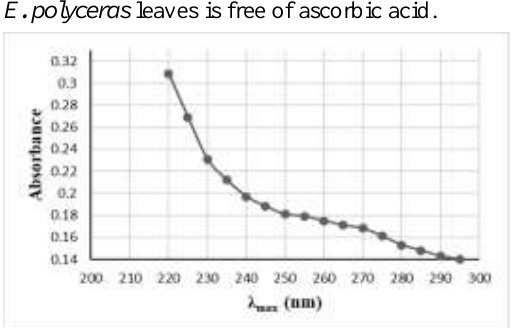
Figure 4.The scanning of leaves extract solution Quercetin calibration curve The concentrations of Quercetin and there absorbances are shown in Table (4). Also, the linearity and the regression equation are shown in Figure (5). Table 4. Quercetin concentrations and their